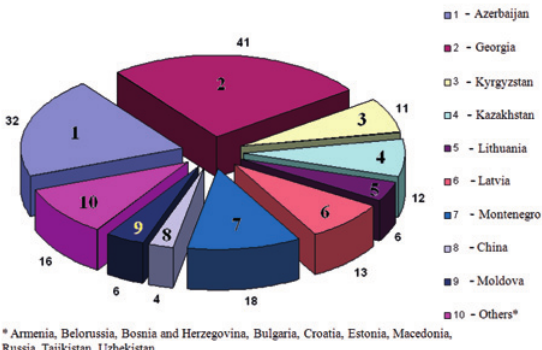
Fig. 3. The number of trainees who took part in the aviation security training courses at the ICAO Training Institute in 2011 The majority of States face challenges causing a lack of human